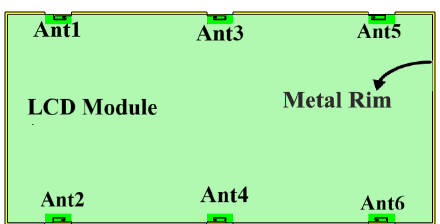
Figure 14. Simulation model for the proposed multiple antenna system with the display module.